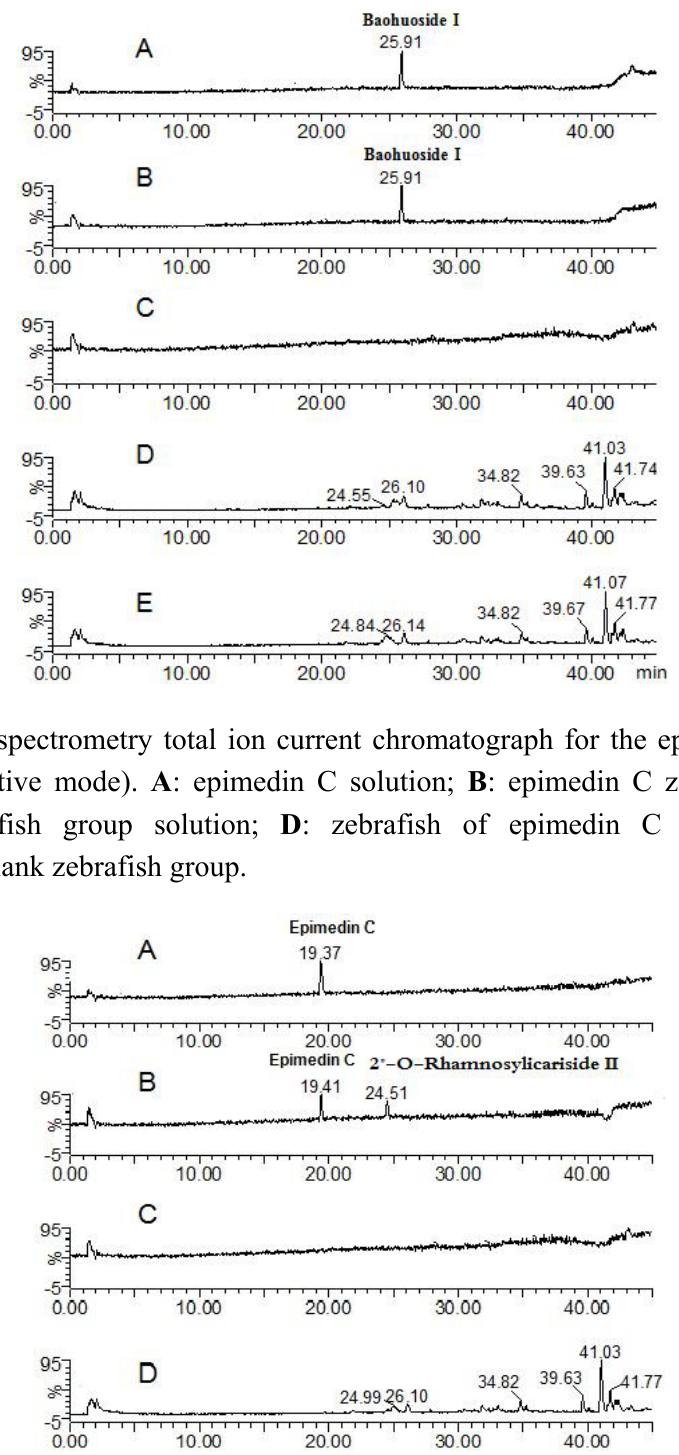
Figure 3. Mass spectrometry total ion current chromatograph for the baohuoside I groups at 24 h (negative mode). A : baohuoside I solution; B : baohuoside I zebrafish solution; C : blank zebrafish solution; D : zebrafish of baohuoside I zebrafish; E : zebrafish of blank zebrafish.